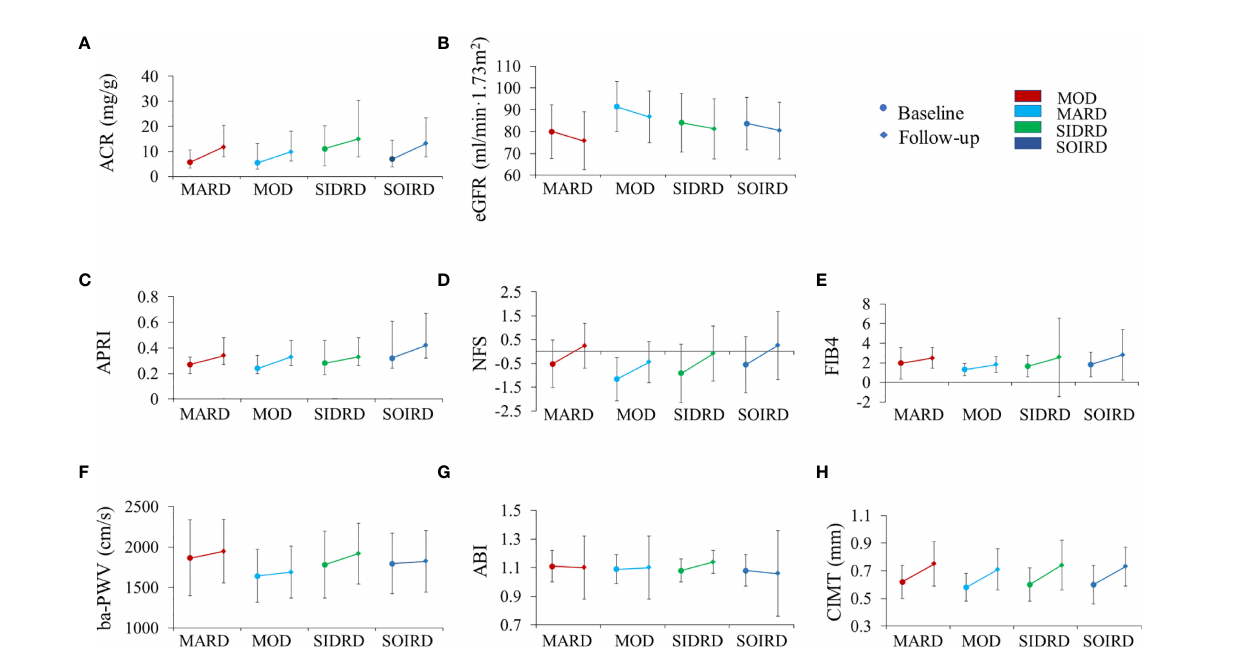
FIGURE 3 | The progression of chronic complications during follow-up by clusters. Plots show levels of ACR (A) , eGFR (B) , APRI (C) , NFS (D) , FIB4 (E) , ba-PWV (F) , ABI (G) , and CIMT (H) . Levels are shown for patients with data available at both baseline (circles) and follow-up (diamond). Data are expressed as mean (SD) for variables with normal distribution or median (IQR) for variables with skewed distribution. P values for paired t-test between baseline and follow-up by clusters are presented in Supplementary Table 3 . MARD, mild age-related diabetes; MOD, mild obesity-related diabetes; SIDRD, severe insulin-de fi cient and insulin-resistant diabetes; SOIRD, severe obesity-related and insulin-resistant diabetes. ACR, urinary albumin-creatinine ratio; eGFR, Estimated glomerular fi ltration rate; APRI, aspartate amino transferase/platelet ratio index; NFS, fatty liver disease fi brosis score; FIB4, fi brosis-4 index; ba-PWV, brachial to ankle pulse wave velocity; ABI, ankle-brachial index; CIMT, carotid intima-media